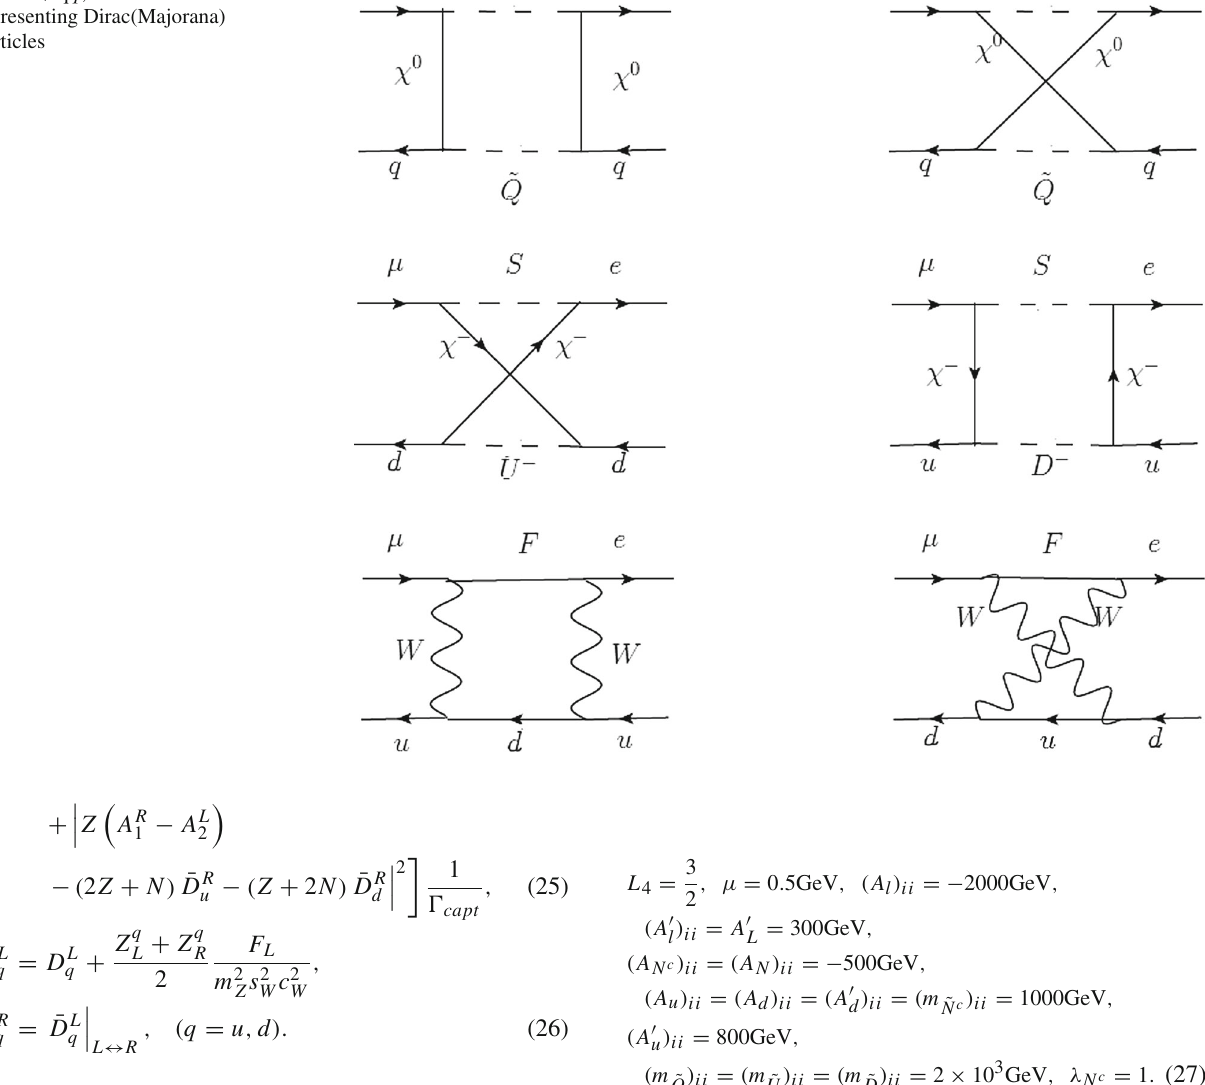
Fig. 2 The box diagrams for μ → e + q ¯ q , with F representing Dirac(Majorana)